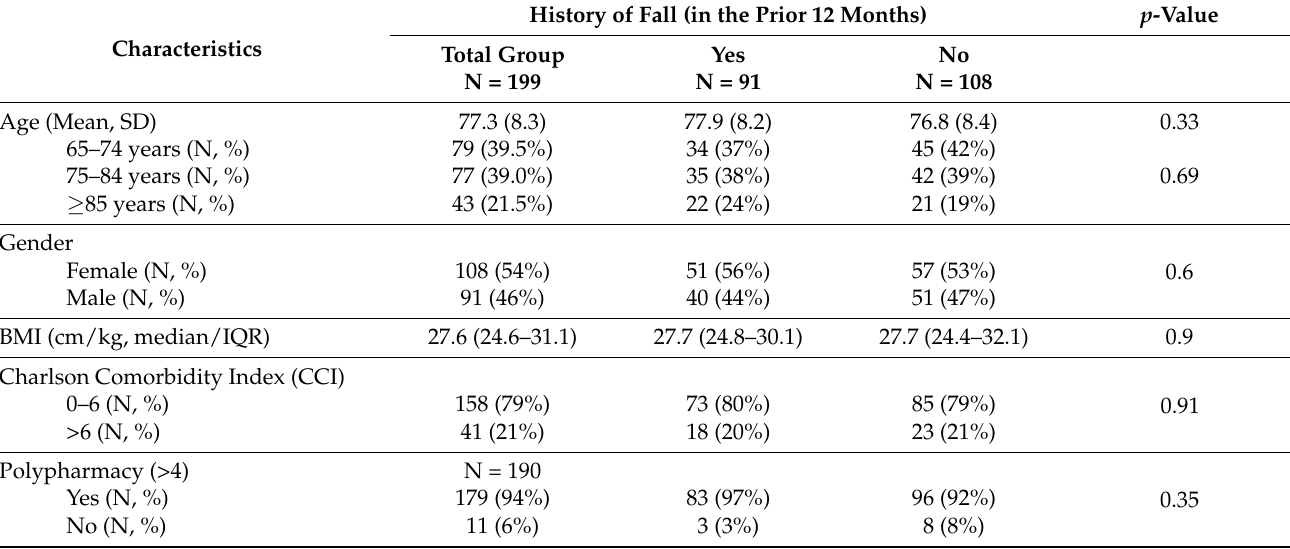
Table 1. Demographic data of study subjects.